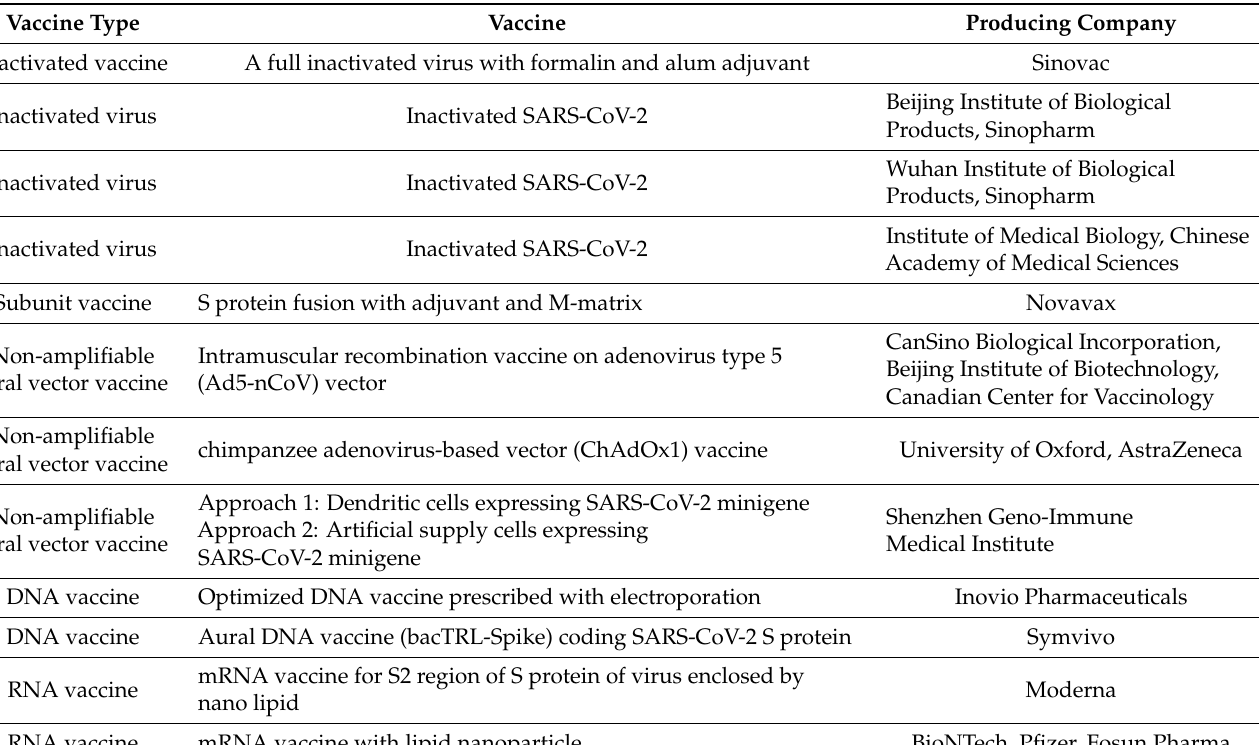
Table 3. Vaccines candidate for the COVID-19